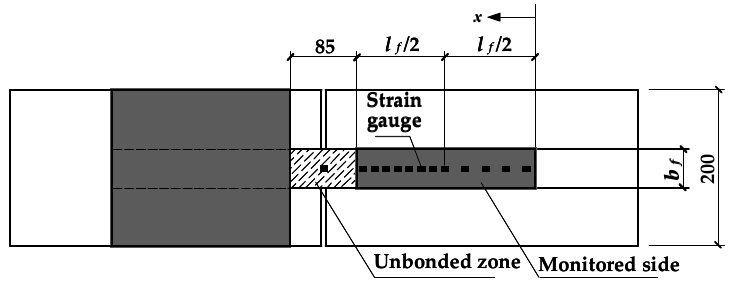
Figure 2. Locations of strain gauges (unit: mm).